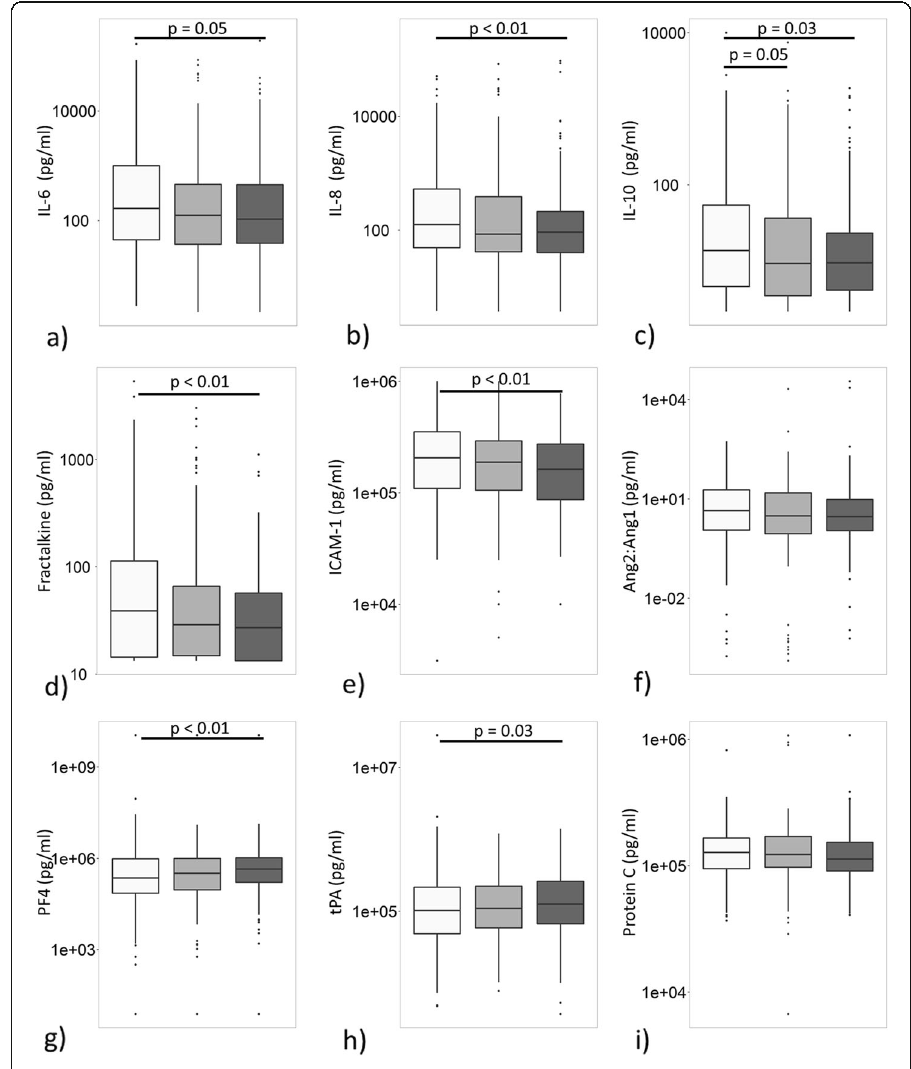
Fig. 3 Systemic levels of biomarker in ARDS patients stratified by age group. Systemic levels of a interleukin (IL)-6, b IL-8, c IL-10, d Fractalkine, e intracellular adhesion molecule (ICAM)-1, f angiopoetin 2:angiopoetin 1 (ANG2:ANG1), g platelet factor (PF) 4, h tissue plasminogen activator (tPA), i protein C, at onset of ARDS. Young adults, middle-aged adults, and elderly. Box and whisker diagrams depict the median and lower quartile, upper quartile, and their respective 1.5 IQR as whiskers — as specified by Tukey. Group differences between young adults and middle-aged adults, and young adults and elderly were tested by a Mann-Whitney U test. A p value < 0.05 was considered as statistical